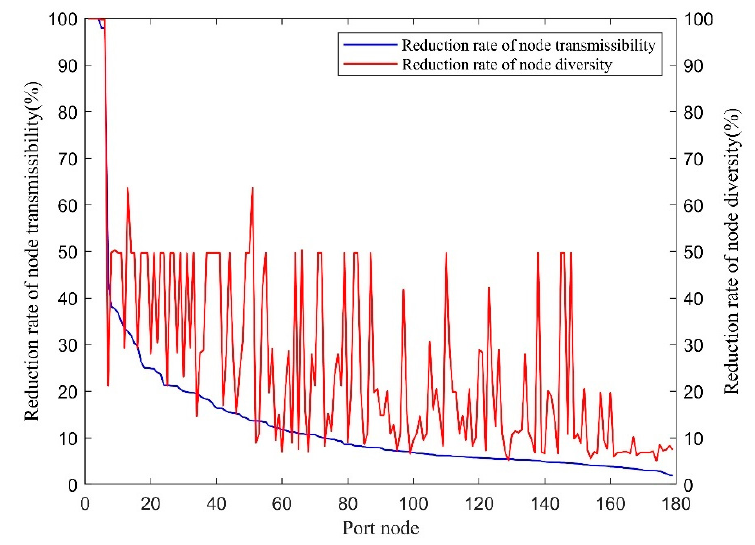
Figure 4. Port node resilience reduction under maximum disturbance state.